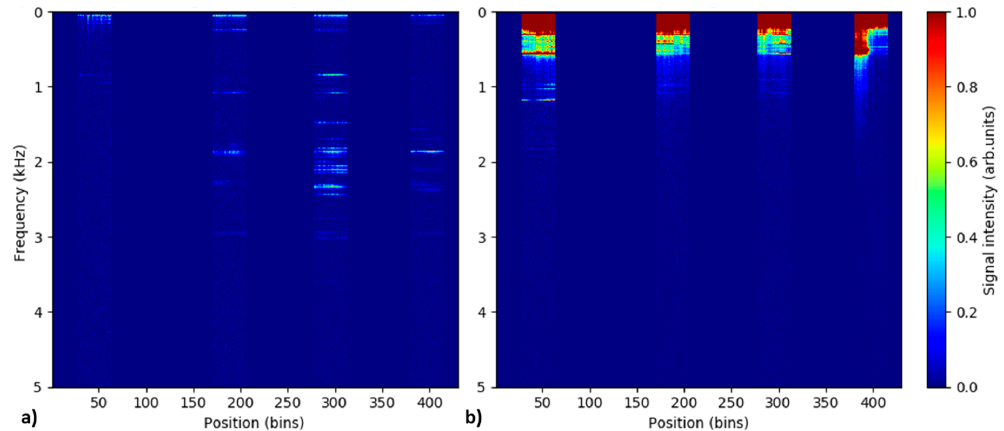
Figure 11. Time-averaged DAS signal spectra along the fiber recorded for 1 mm leak at 10 bars ( a ) and for airflow through the leak-free pipeline at atmospheric pressure and flow speed of 70 m/s ( b ). Signals from fiber dead-zones between the monitored pipe zones are discarded, i.e., set to zero.